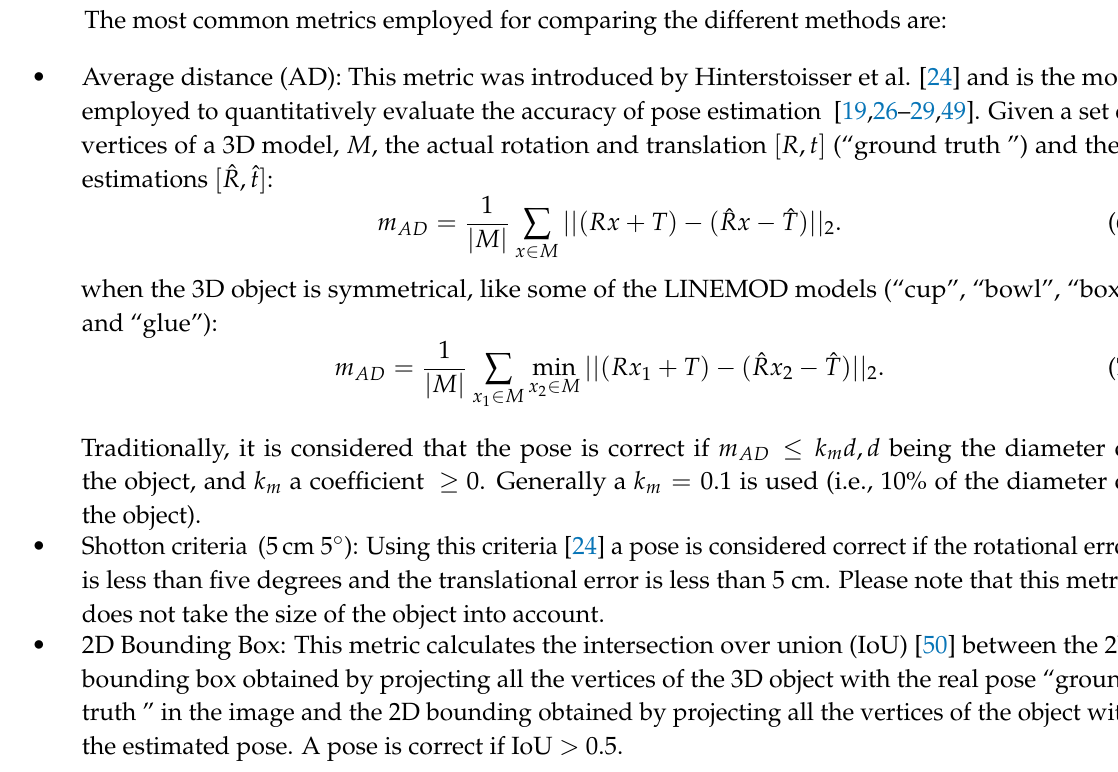
Figure 6. Some 3D models of the LINEMOD